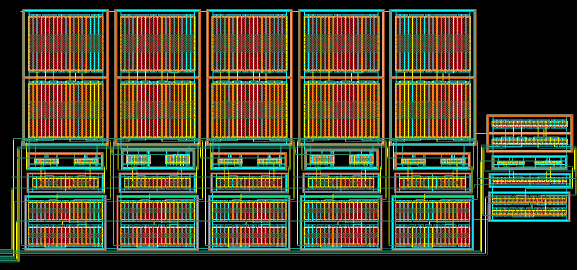
Figure 16. Layout of our proposed OTA fractional-order integrator to approximate 1/ s 0.9 . The post-layout simulation of our proposed CMOS fractional-order integrator H ( s ) = 1/ s 0.9 , has very low error compared to the ideal transfer function in the MatLab- evaluation from (7), compared to the OTA macro-model simulation from Figure 5, and compared to the HSPICE simulation using MOS transistor models, as shown in Figure 17. This guarantees exactness in the implementation of FOCOs.